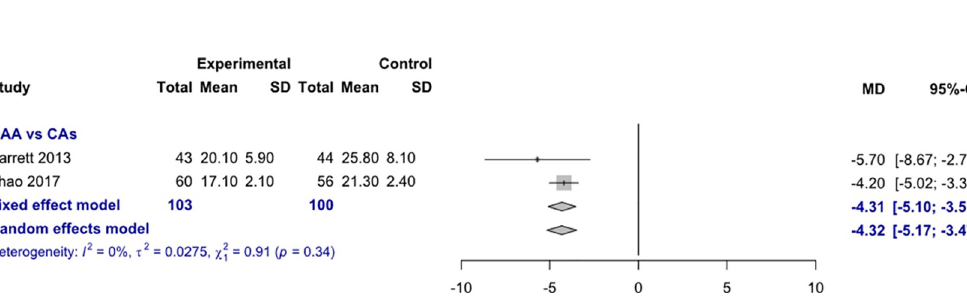
PLOS ONE | https://doi.org/10.1371/journal.pone.0255888 August 24,